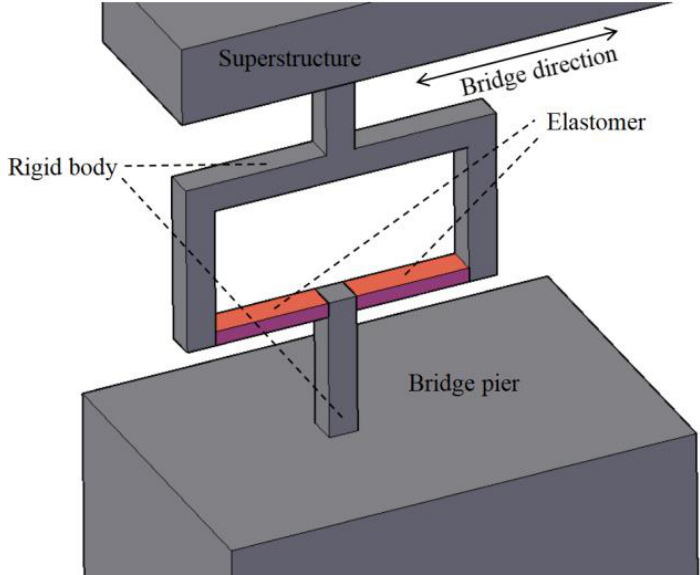
Figure 1. Schematic illustration of the inclinometer setup.